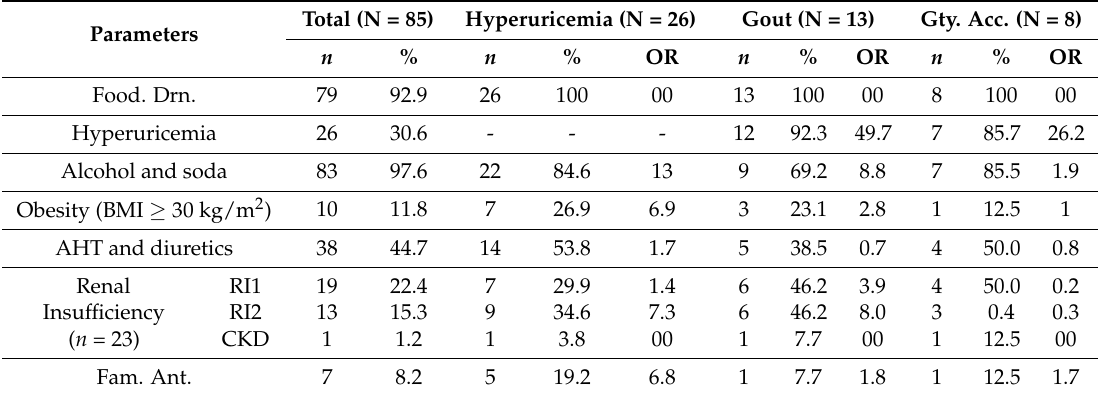
Table 3. Risk factors and diseases associated with hyperuricemia, gout and/or gouty access in the included population ( n = 85).